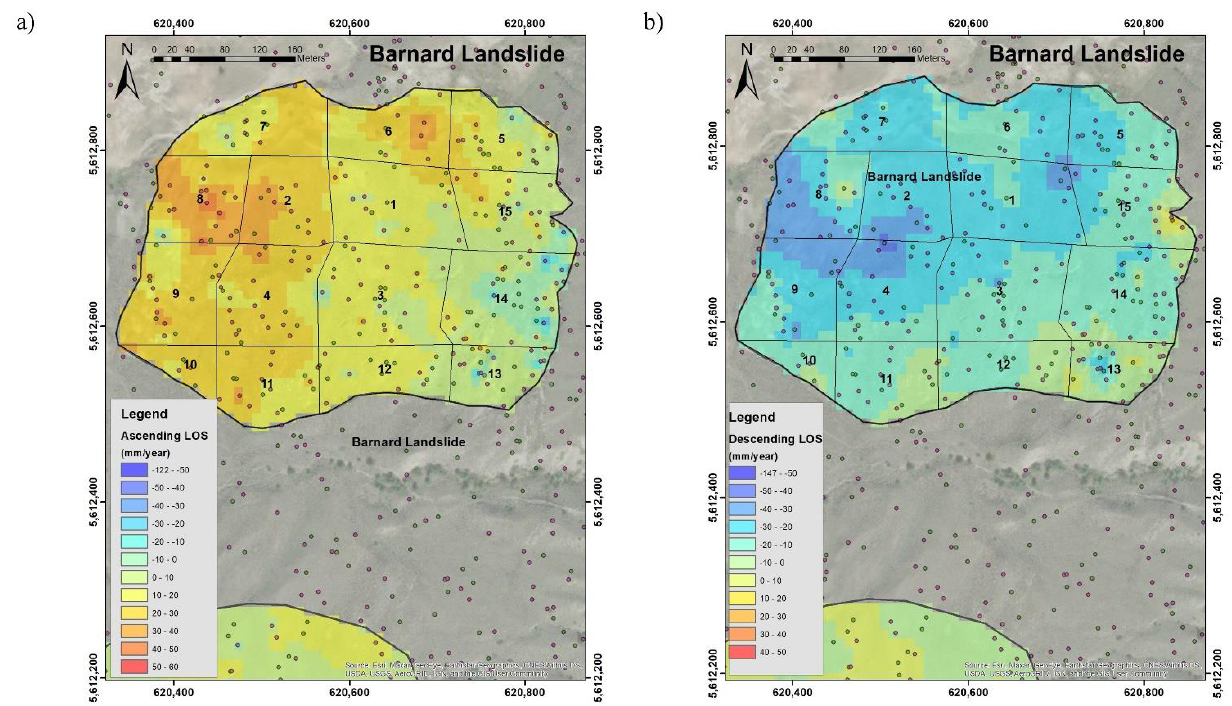
Figure 20. Cumulative 2-year LOS displacement for the Barnard landslide for ( a ) Sentinel ascending and ( b ) Sentinel descending orbits.